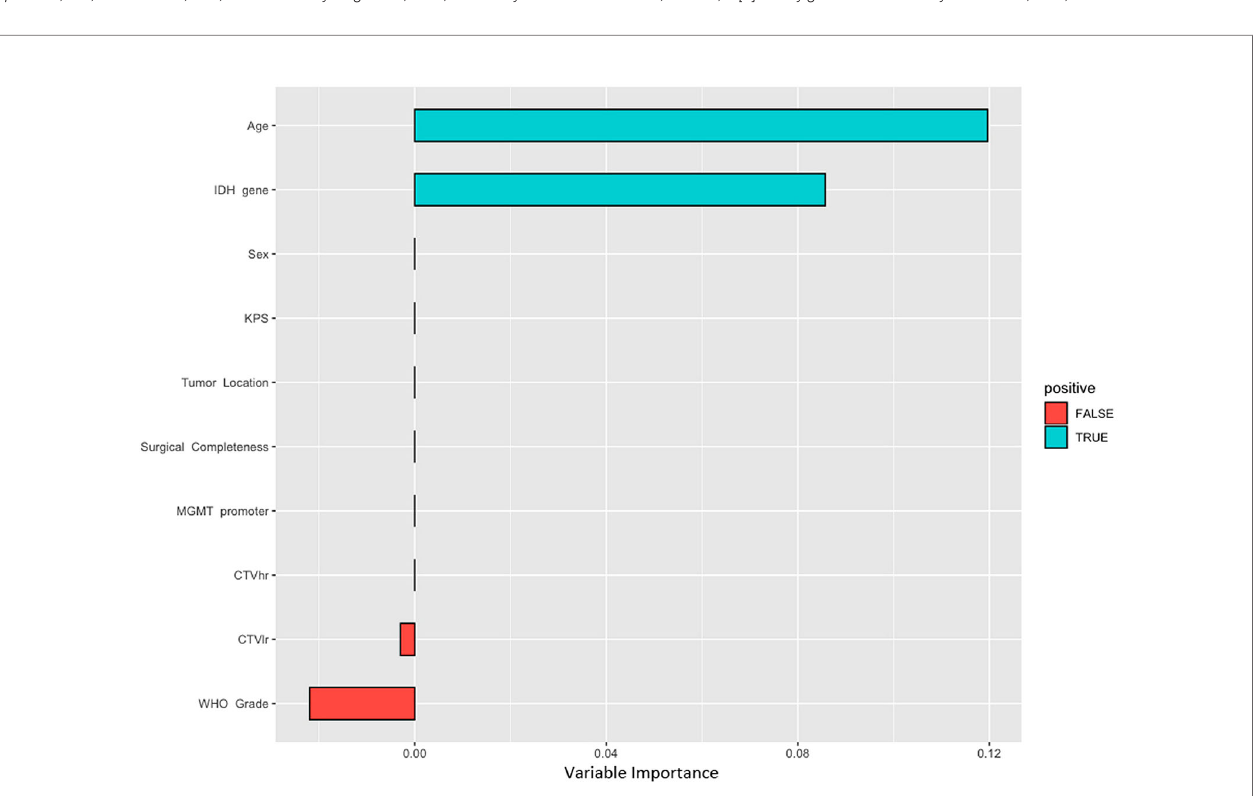
FIGURE 4 | Variable importance of indicated by random forest survival